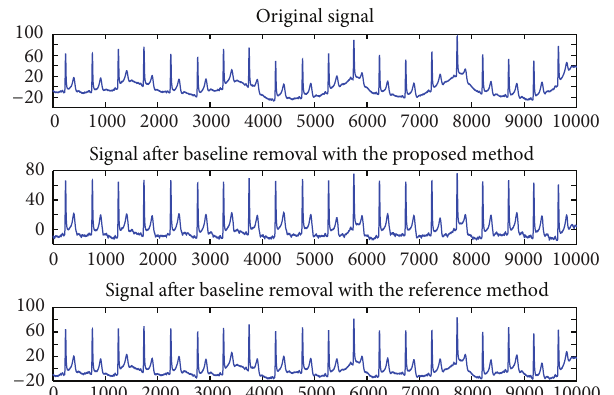
Figure 10: Comparison of the proposed method to the reference